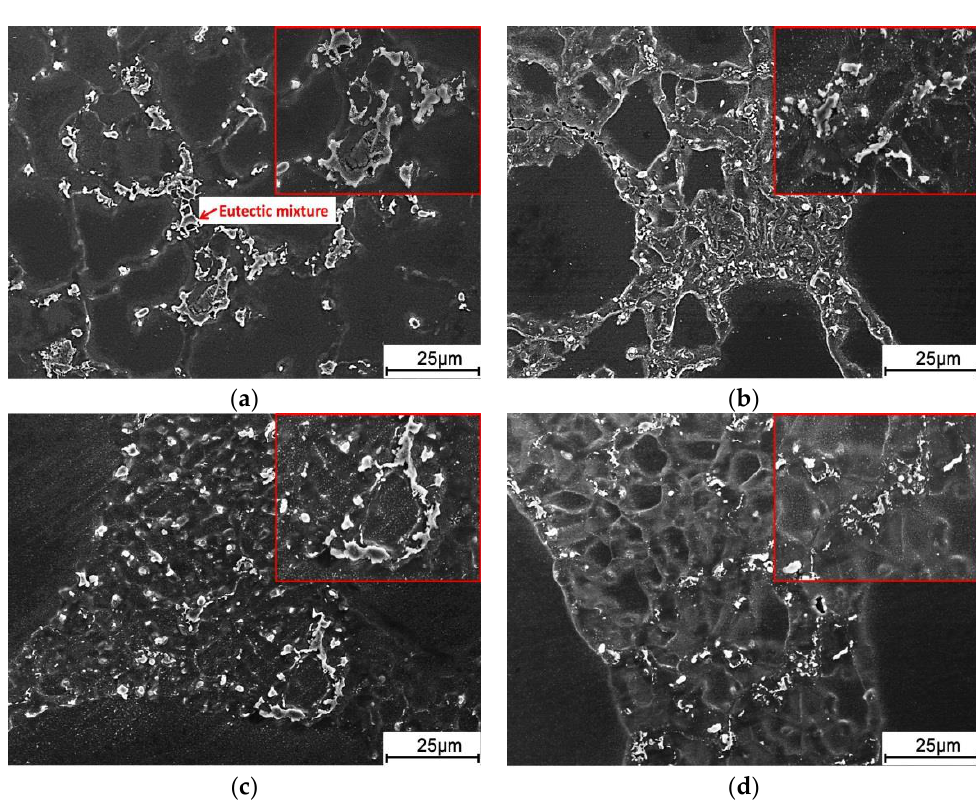
Figure 8. SEM pictures of secondary solidification region in rheo-diecast AZ31 alloy, with solid fractions of 42% ( a , c ) and 61% ( b , d ) at different injection velocities. ( a , b ) 0.5 m/s; ( c , d ) 3 m/s.